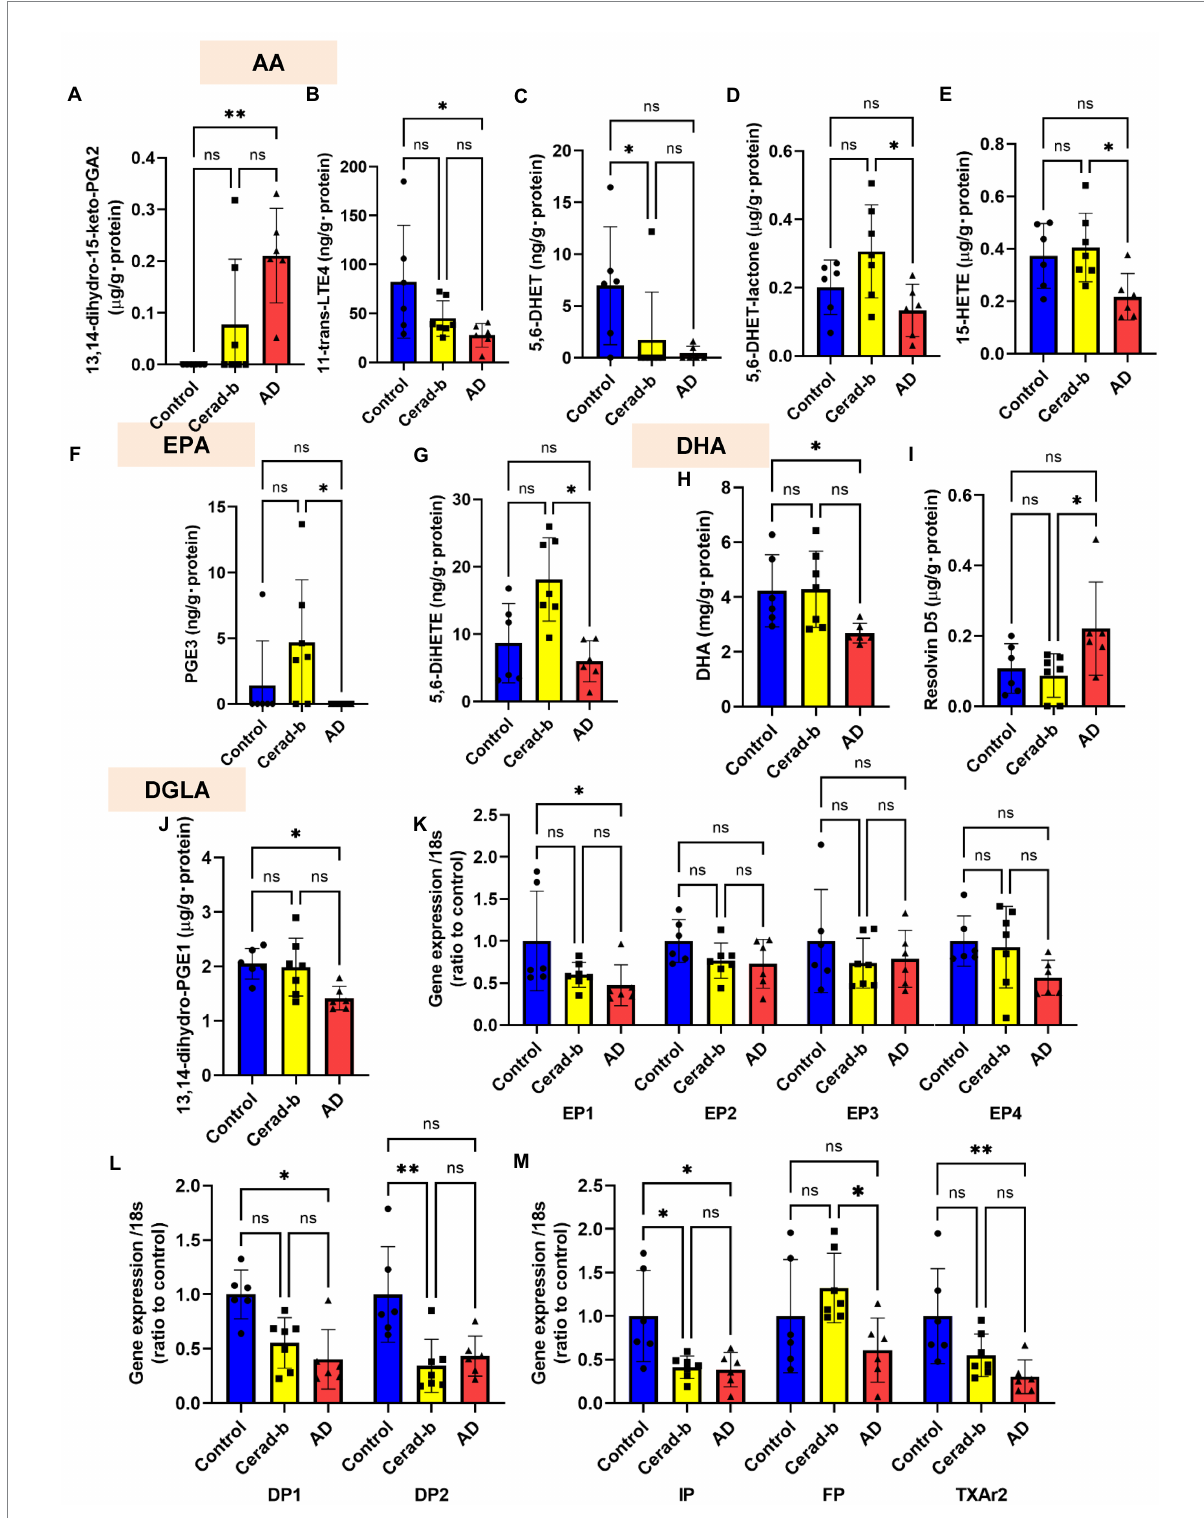
FIGURE 4 Modulations of the levels of eicosanoids and related mediators, and the eicosanoid receptor mRNA levels in the brains in AD and Cerad-b. The levels of eicosanoids and related mediators and the mRNA expression levels of the eicosanoid receptors were measured in the brains of control subjects ( n = 6), patients with Cerad-b ( n = 7), and patients with AD ( n = 6). The Kruskal-Wallis test, followed by the Steel-Dwass test as a post-hoc test, was used for statistical evaluations of the differences. (A) 13,14-dihydro-15-keto PGA2 levels. (B) 11-trans-LTE4 levels. (C) 5,6-DHET levels. (D) 5,6-DHET- lactone levels. (E) 15-HETE levels. (F) PGE3 levels. (G) 5,6-DiHETE levels. (H) DHA levels. (I) Resolvin D5 levels. (J) 13,14-dihydro-PGE1 levels. (K–M) The mRNA levels of the eicosanoid receptor, GPR55, adjusted to that of 18 s as the internal standard. * p < 0.05; ** p < 0.01; ns, not